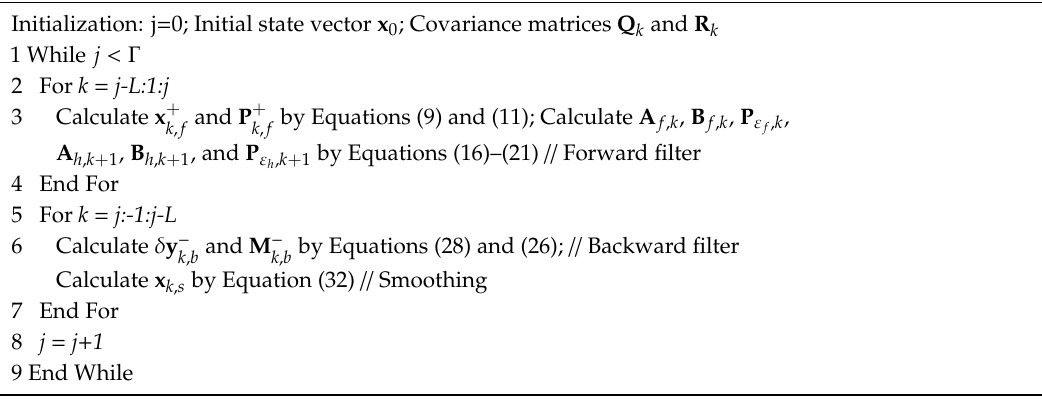
Algorithm 1: FLEnKS (fixed-lag ensemble Kalman